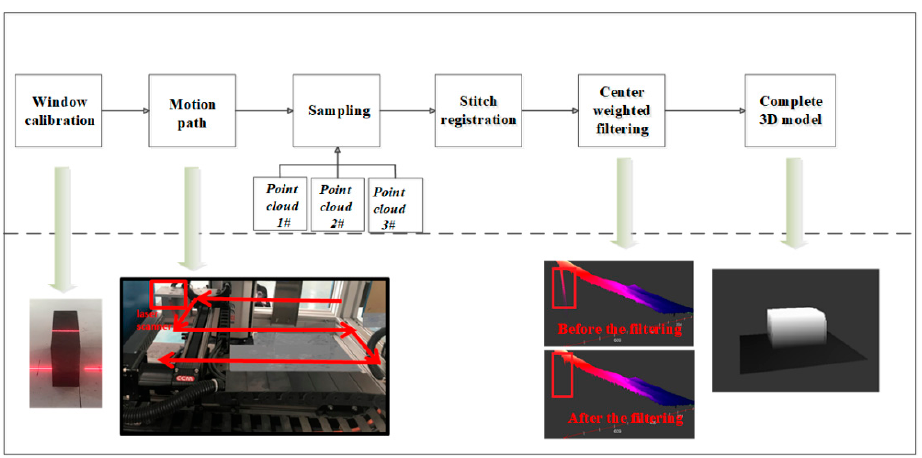
Figure 2. Block diagram of topographic survey process.